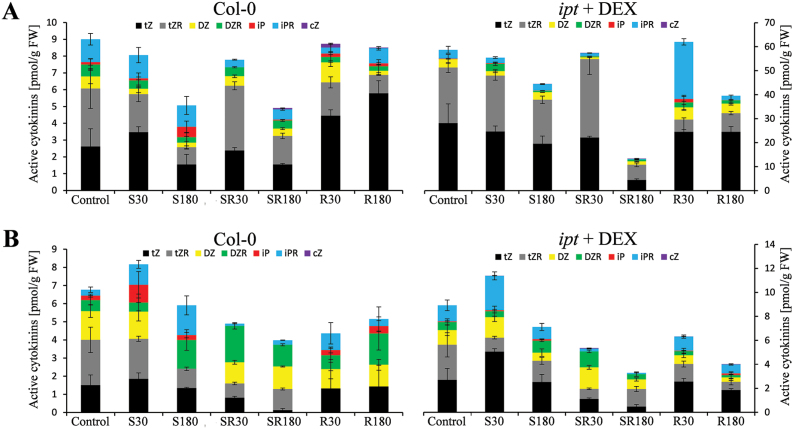
The content of active cytokinins in leaves (A) and roots (B) after exposure to different HS treatments in wild-type (Col-0) and DEX-induced trasngenic plants. Data represent means±SD from two independent biological experiments with three replicates for each bar. tZ, trans-zeatin; tZR, trans-zeatin riboside; DZ, dihydrozeatin; DZR, dihydrozeatin riboside; iP, isopentenyladenine; iPR, isopentenyladenosine; cZ, cis-zeatin. S30, 30-min HS applied to shoots; S180, 180-min HS applied to shoots; SR30, 30-min HS applied to shoots and roots; SR180, 180-min HS applied to shoots and roots; R30, 30-min HS applied to roots; R180, 180-min HS applied to roots HS.